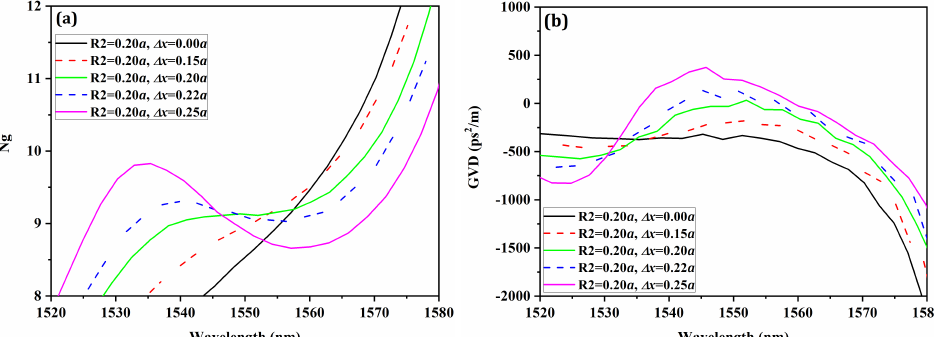
Figure 5. ( a ) The calculated group index and ( b ) Calculated GVD parameters, where R2 = 0.20 a and a is equal to 380 nm.